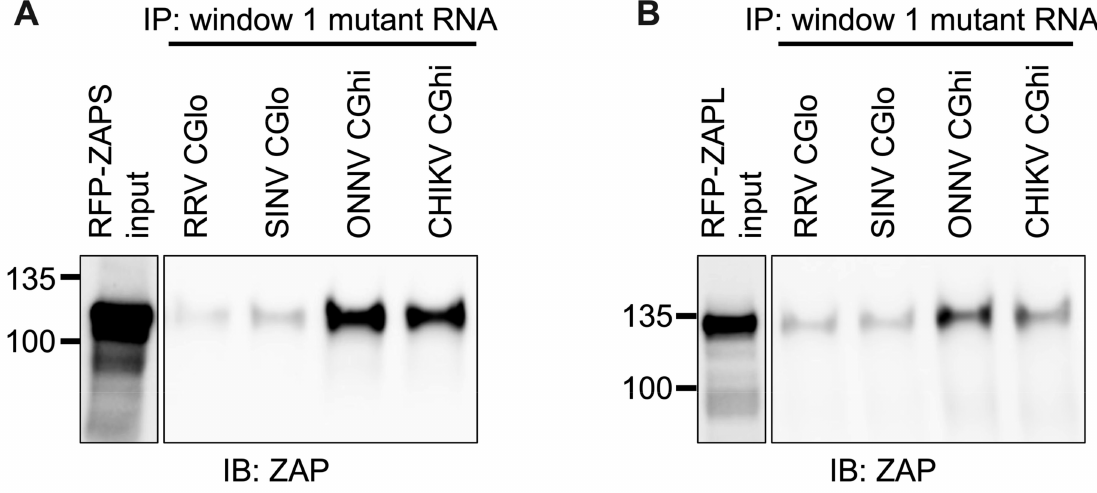
Figure 8. ZAPS and ZAPL binding to CpG-correlated window 1 is CpG-dependent. Lysates of ZAP KO 293T cells with induced expression of RFP-ZAPS ( A ) or RFP-ZAPL ( B ) were incubated with biotinylated RRV CGlo, SINV CGlo, ONNV CGhi, or CHIKV CGhi window 1 mutant RNA. Following streptavidin-mediated pull-down of biotinylated RNA, ZAP associated with each RNA and in whole cell lysate (input) was assayed by immunoblot. Expected sizes: RFP-ZAPS = 106 kDa, RFP-ZAPL = 130 kDa. Data are representative of results from three independent